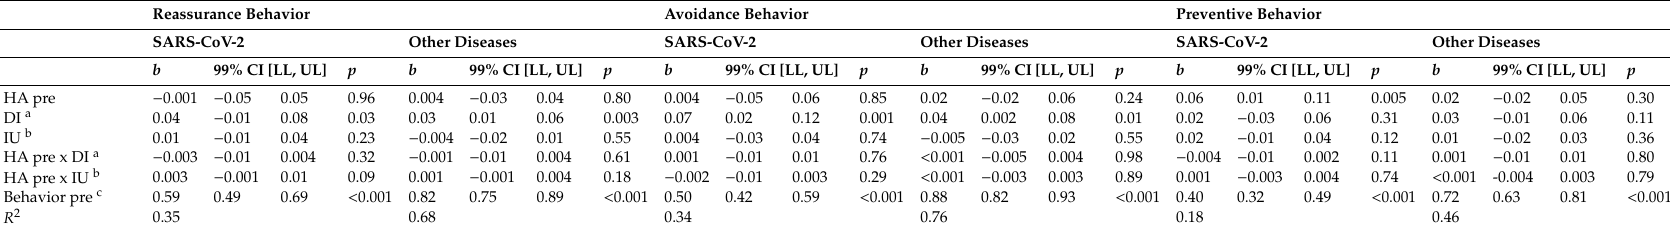
Table 4. Results of the moderator analyses on behavior during COVID-19 with health anxiety (SHAI) pre COVID-19 (retrospectively assessed) as predictor and intolerance of uncertainty [IU-18] and distress intolerance [Distress intolerance scale] as moderators. Reassurance Behavior Avoidance Behavior Preventive Behavior SARS-CoV-2 Other Diseases SARS-CoV-2 Other Diseases SARS-CoV-2 Other Diseases